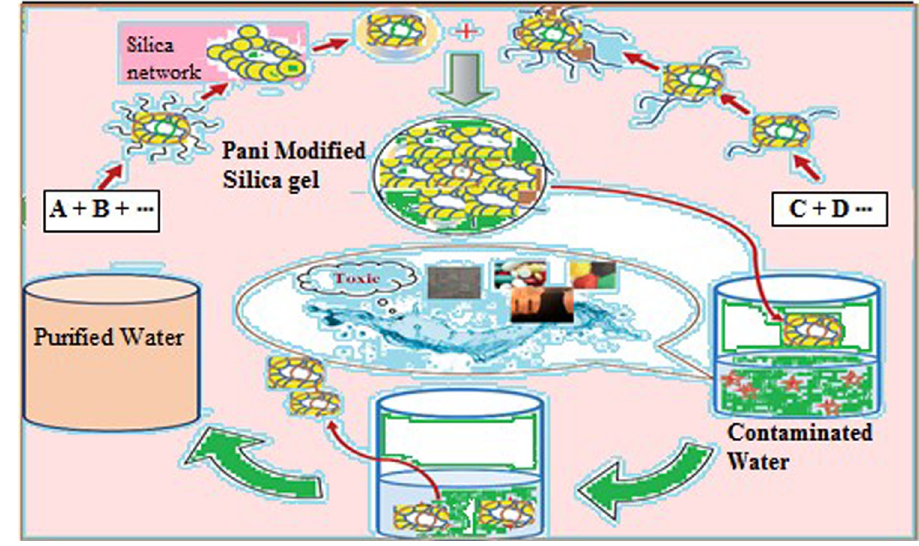
Figure 3: Overview of Pani@SG materials focuses on their adsorption strategies for water